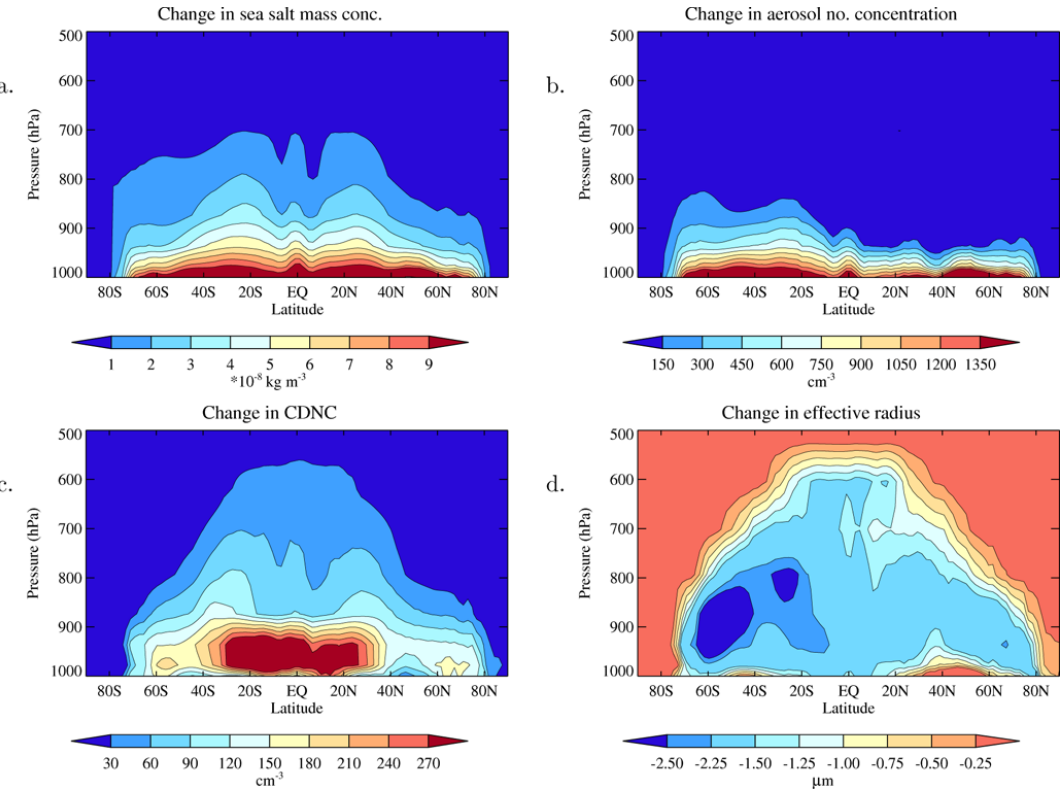
Fig. 8. Zonally averaged changes in (NorESM): (a) sea salt mass concentration (kgm − 3 ), (b) aerosol number concentration (cm − 3 ), (c) cloud droplet number concentration (cm − 3 ), and (d) effective cloud droplet radius (µm). All annual